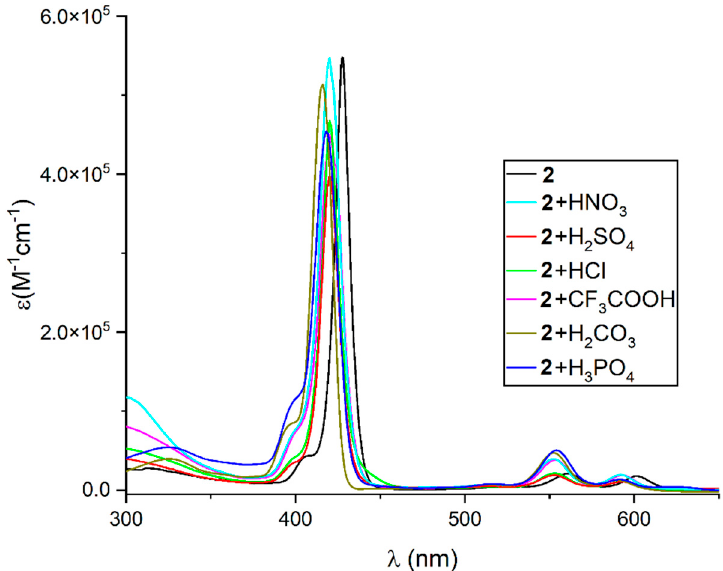
Figure 2. UV-visible spectra of compound 2 and its different ionic complexes in CHCl 3 .